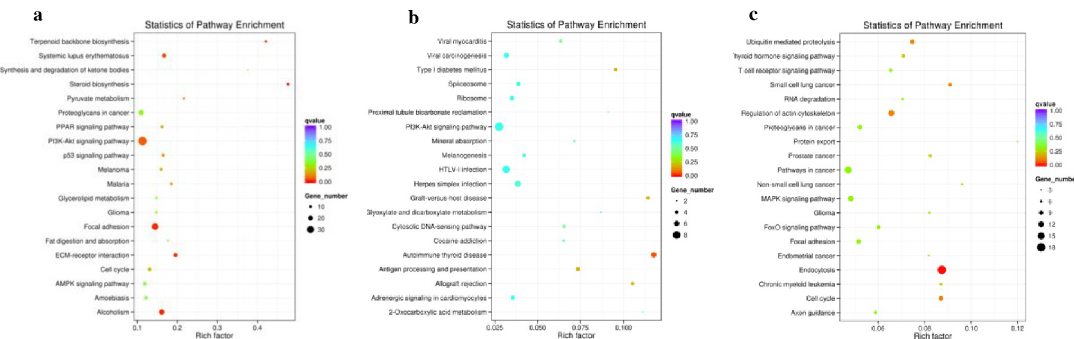
Fig 7. Kyoto Encyclopedia of Genes and Genomes (KEGG) enrichment analysis of differentially expressed genes between day 8 and day 0. (a) KEGG enrichment analysis of differentially expressed mRNAs. (b) KEGG enrichment analysis of differentially expressed lncRNAs with their cis-acting mRNA. (c) KEGG enrichment analysis of differentially expressed circRNAs.